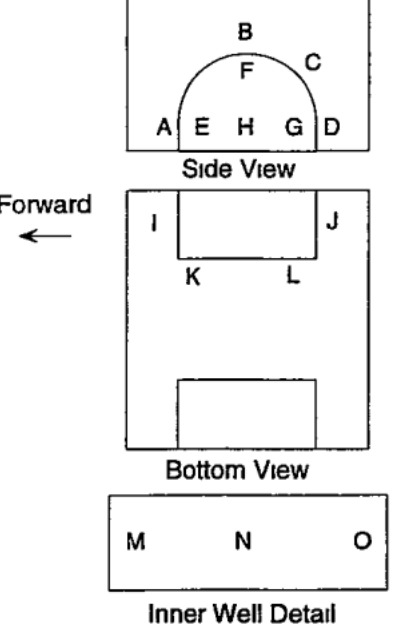
Figure 3. Cavity region labels by Fabijanic